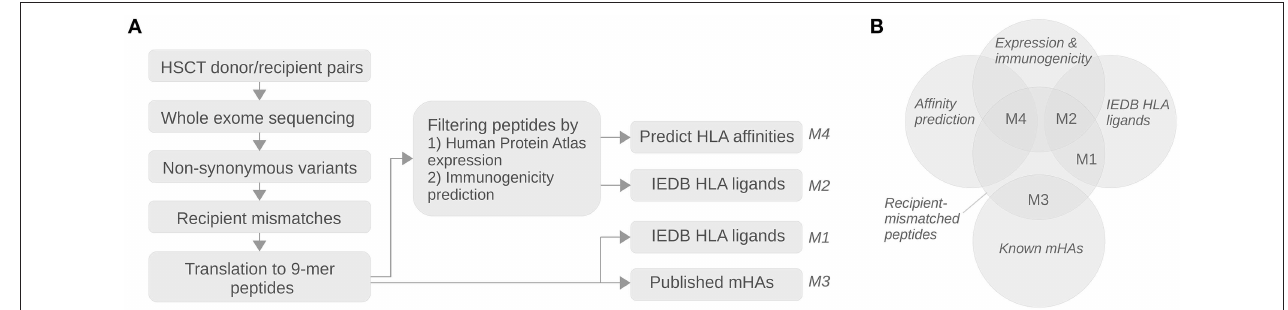
FIGURE 1 | Schematic diagram of the analysis pipeline. (A) The vertical arrows in top-down direction in the diagram show the processing steps for translating whole exome sequencing data into recipient-mismatched peptide sets. The horizontal arrows in left-to-right direction show the analysis steps involved in sub-setting the mismatched peptides into sets relevant for alloreactivity; in the first step the peptides are filtered for epithelial expression and immunogenicity, and in the second step they are intersected with experimental HLA ligand databases or HLA affinity predictions according to each pair’s HLA class I type. Finally, the obtained HLA-presented peptide count estimates from the four analysis approaches (labeled as M1–M4; Table 2 ) are examined for possible association with chronic GvHD. (B) Euler diagram showing the analysis methods M1–M4 as intersections between peptide sets.